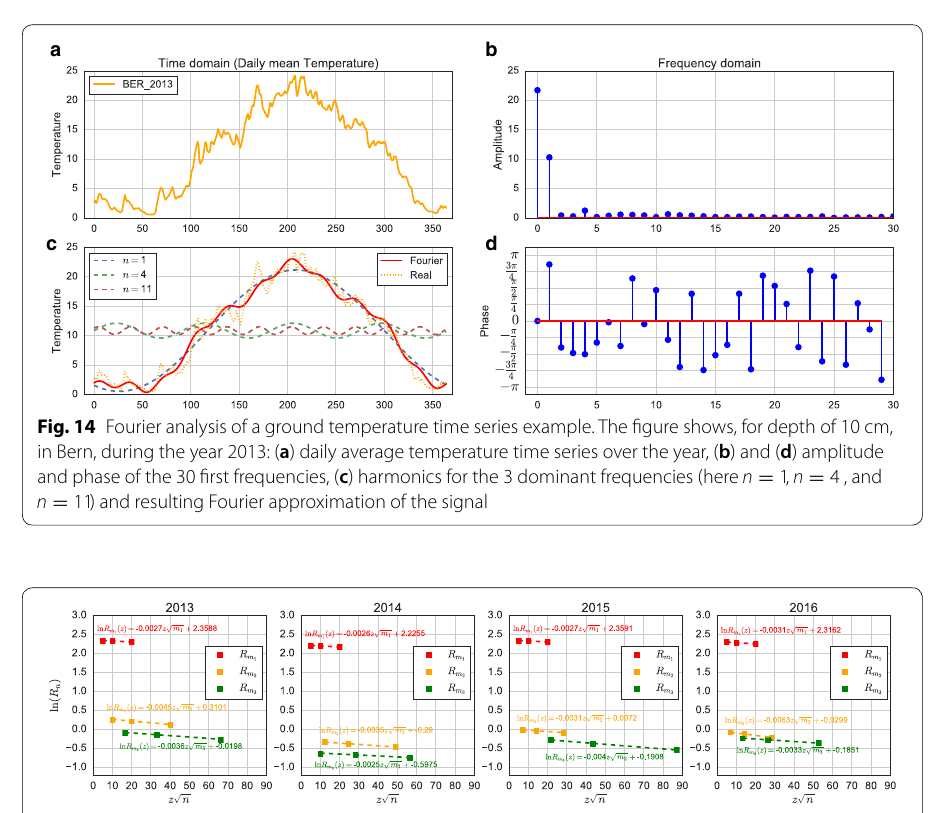
m m m 1 , 2 , 3 ) in Fourier analysis in Bern, in 2013, 2014, 2015, and =